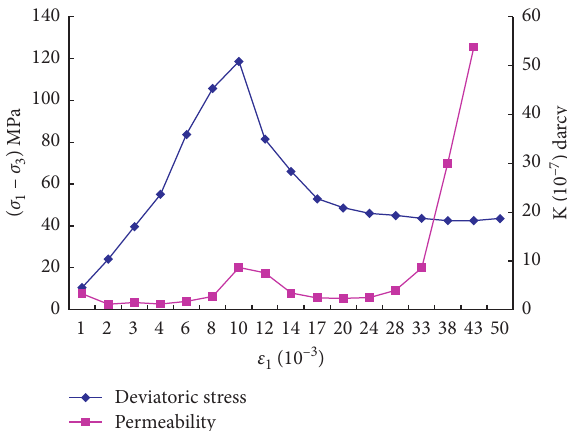
Figure 5: Permeability-principal stress difference curves of W1-1.